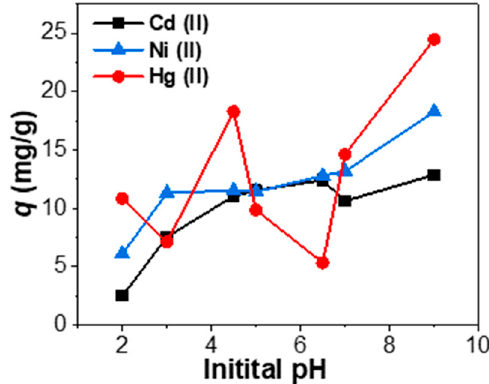
Figure 5. E ff ect of initial pH on Cd(II), Hg(II) and Ni(II) adsorption onto MAAC beads (mean standard Figure 5. Effect of initial pH on Cd (II), Hg (II) and Ni (II) adsorption onto MAAC beads (mean deviation ± standard deviation ± 0.3).